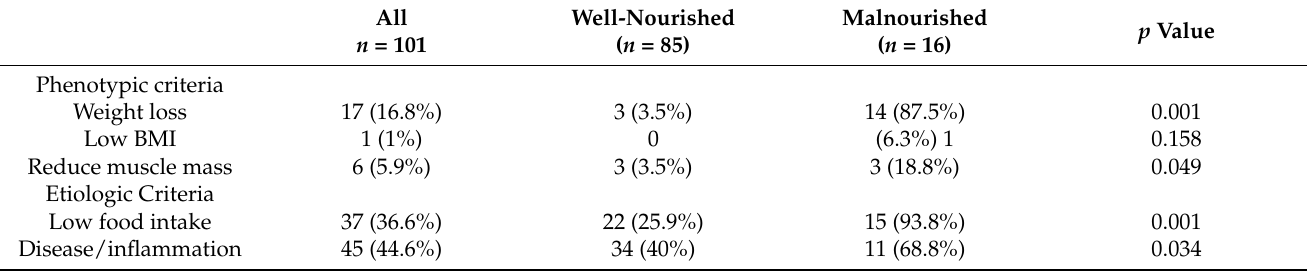
Table 6. Prevalence of phenotypic and etiologic GLIM criteria among patients with